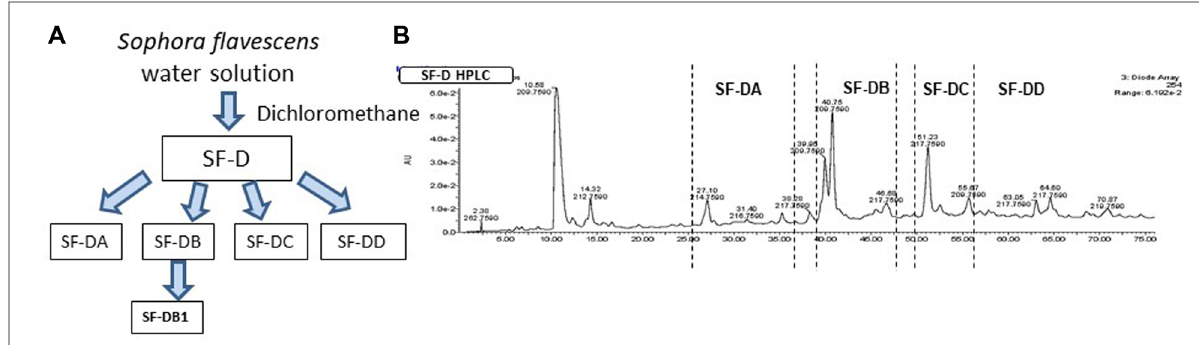
FIGURE 2 Compound isolation process of Sophora fl avescens . ( A ) Flow chart of isolation and puri fi cation process of compounds from Sophora fl avescens . ( B ) HPLC chromatogram of further separation using Auto-Puri fi cation system.